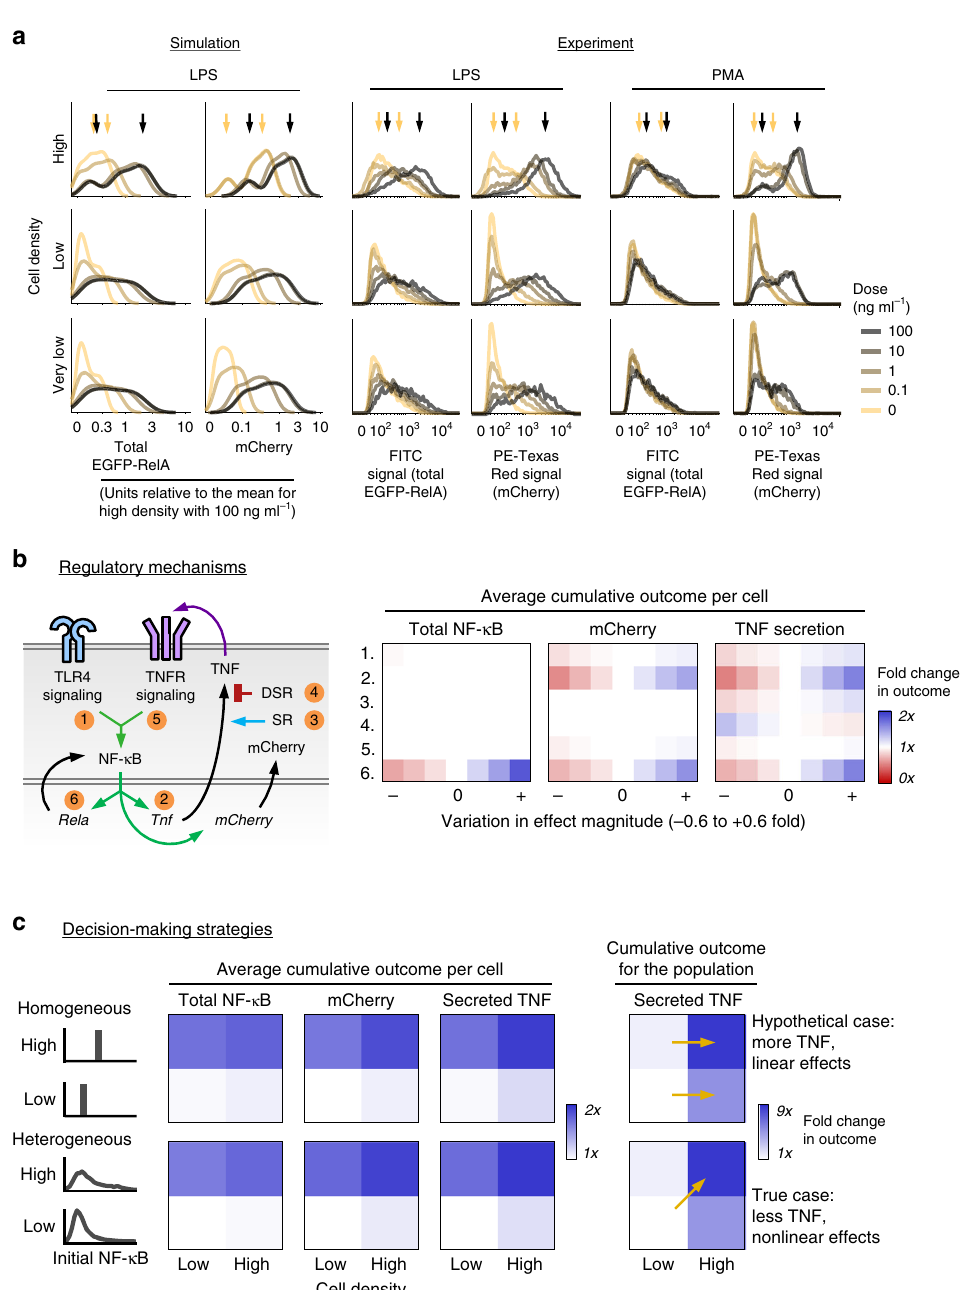
Fig. 4 Mechanisms of TNF regulation differ in phenotypic and functional consequences. a Predicted and measured distributions of reporter expression across cell densities and doses of LPS or PMA at 12 hps. Very low density is 1/8th of low density. Arrows denote modes of the distributions for high density without stimulus or with 100 ng ml − 1 of LPS or PMA. For simulations: low and very low density used the same initial values; mCherry distributions without stimulus were obtained without FBD and without intercellular feedback; and FBD was applied for LPS doses at and above 1 ng ml − 1 . b Simulated outcomes after individually varying the effect magnitudes of mechanisms that regulate TNF, with perturbations numbered and depicted in the diagram. Outcomes were assessed using the 12 hps time-integrated amounts of total EGFP-RelA, mCherry, and secreted TNF (cumulative secreted fl ux) per cell at high density. Conditions corresponding to the zero on the x-axis indicate base case effect magnitudes ( 1× on the color scale). Abbreviations: stabilizing regulation (SR) and destabilizing regulation (DSR). c Comparison of activation for homogeneous (hypothetical) or heterogeneous (observed) initial distributions of transcription factor expression. For each readout, a value of 1× was set for the outcome given a heterogeneous population at low density with low initial values. Homogeneous initial values were set to the mean of corresponding heterogeneous distributions. In the right panel, the effect of the number of cells is incorporated into the total amount of secreted TNF. Arrows indicate comparisons from the main text, and key trends are noted on the right. Source data are provided as a Source Data fi